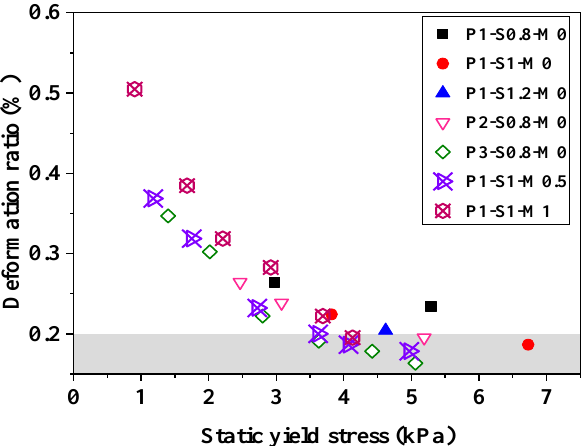
Figure 8. The relationship between static yield stress and deformation ratio of mortar.